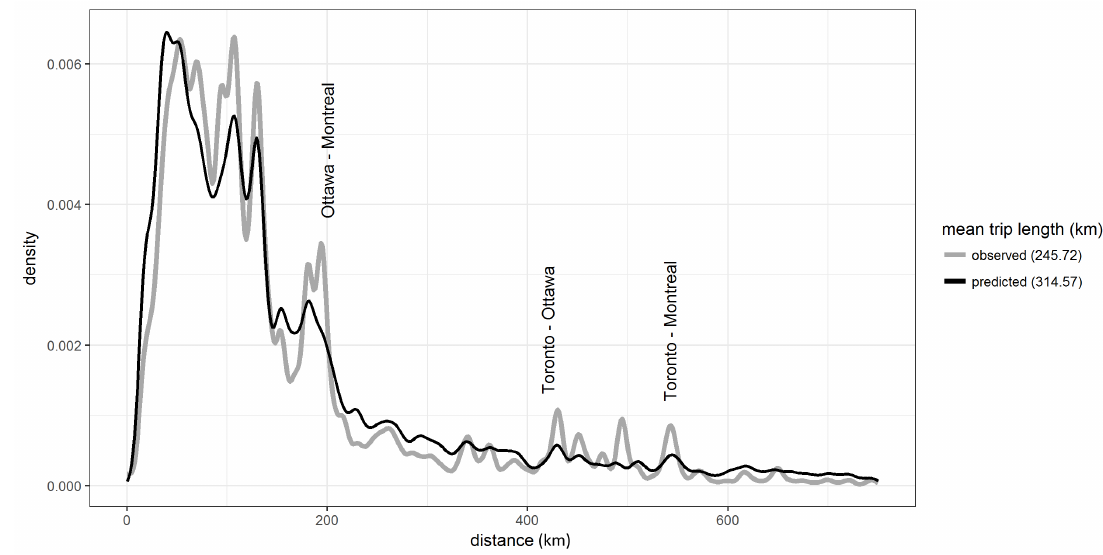
Figure 6. Trip length distribution of model B after calibration (0–750 km